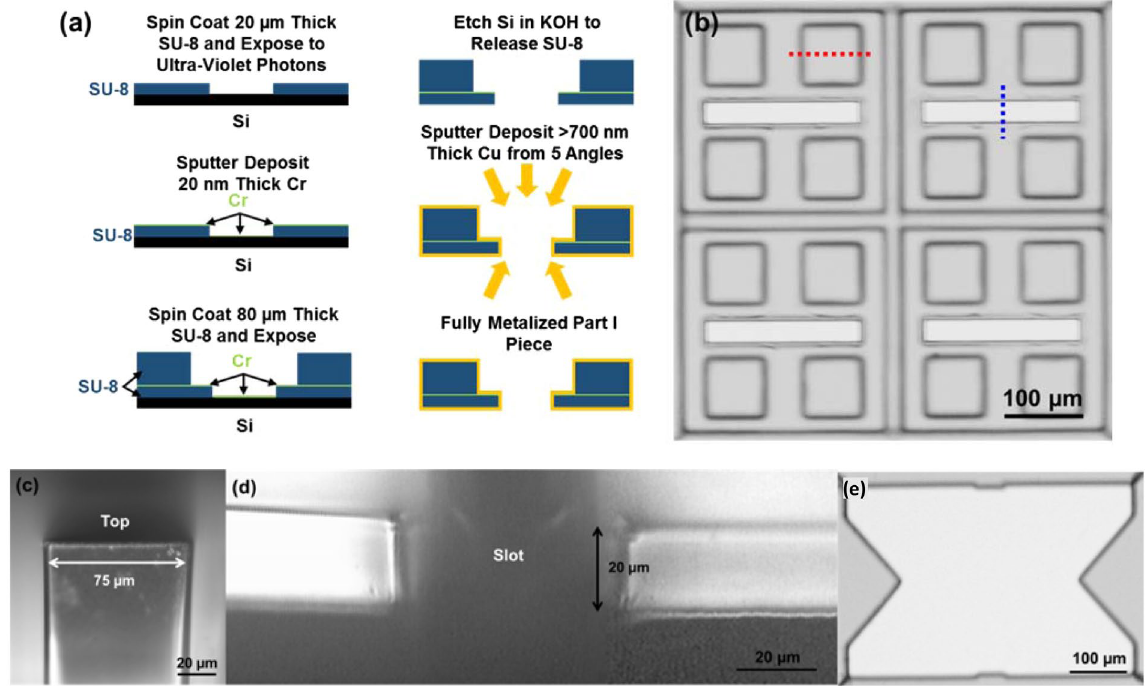
Figure 8. ( a ) Fabrication technology used for double layer structure in the Part I piece. ( b ) Optical micrograph of the Part I piece of the THz antenna. Cross-sections of ( c ) top part of square strut (labelled by red dotted line in ( b ) and ( d ) two sides of slot (labeled by blue dotted line in ( b ). ( e ) Optical micrograph of the Part II piece of the THz antenna.